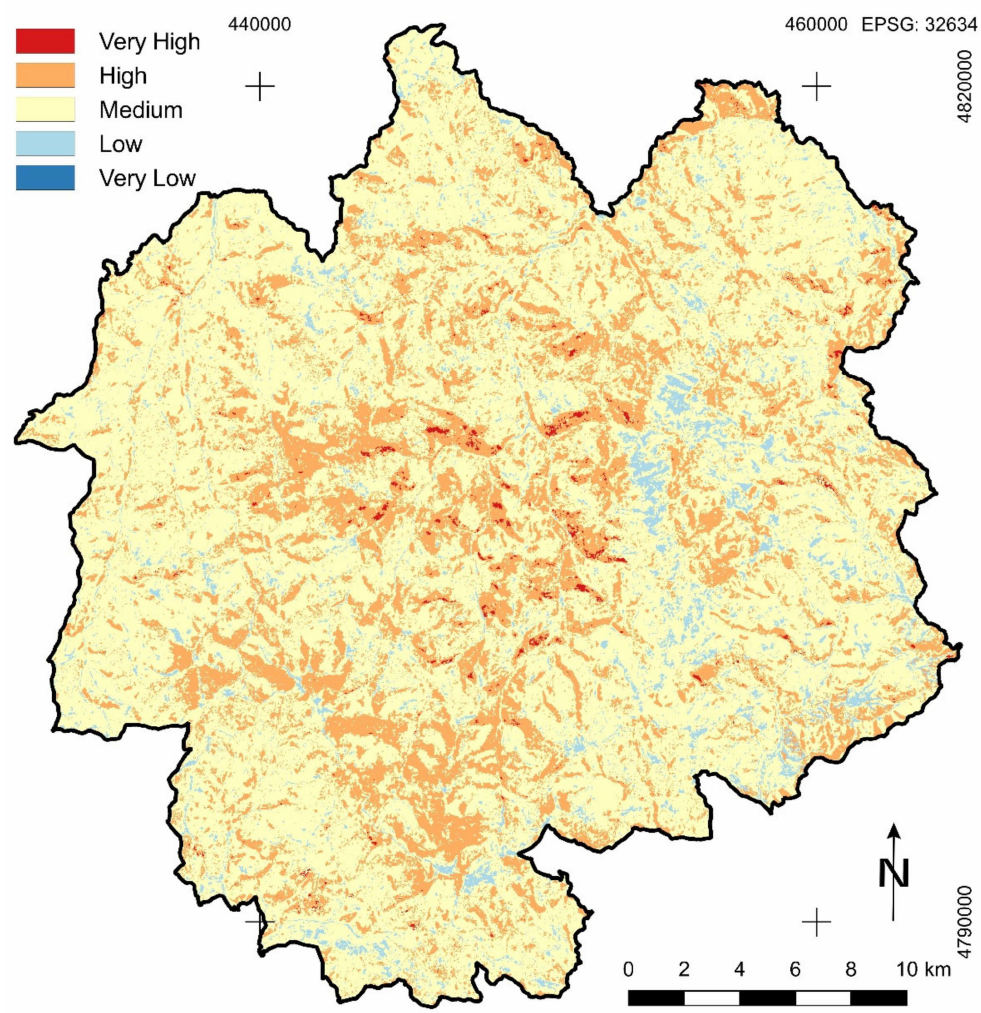
Figure 6. Forest fire susceptibility zones in the Nature Park Golija, according to the Forest Fire Susceptibility Index